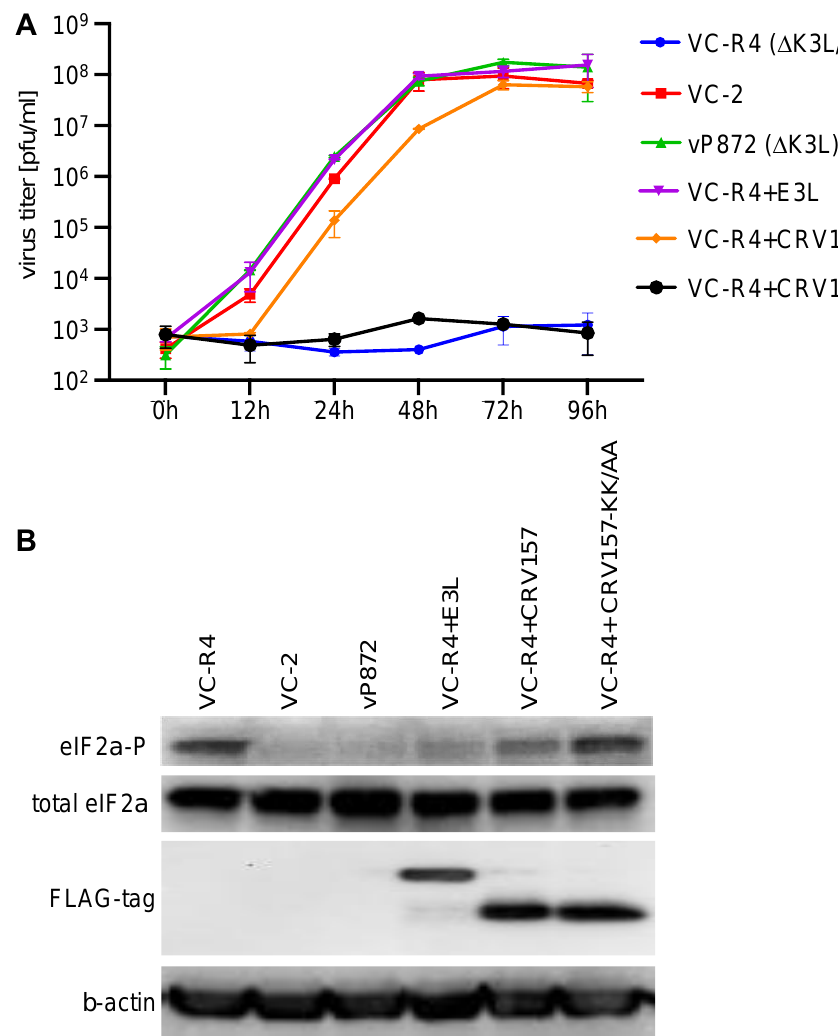
Figure 7. Rescue of VACV replication by CRV157 in RK13 cells. ( A ) RK13 cells were infected at MOI = 0.01 with wild-type VACV-Copenhagen (VC-2), vP872 (VACV ∆ K3L), VC-R4 (VACV ∆ E3L ∆ K3L), or VC-R4 recombinants containing either E3L, CRV157, or CRV157-KK-AA. After the indicated time points, cell lysates were collected, and virus production was determined by titering on RK13+E3L+K3L cells. Standard deviations of two independent infections are shown. ( B ) Total protein lysates were collected from RK13 cells infected (MOI = 3) with the indicated viruses 6 h post-infection, and analyzed by Western blot analysis with antibodies specific for phosphorylated (P) or total eIF2 α , FLAG tag, or β -actin.